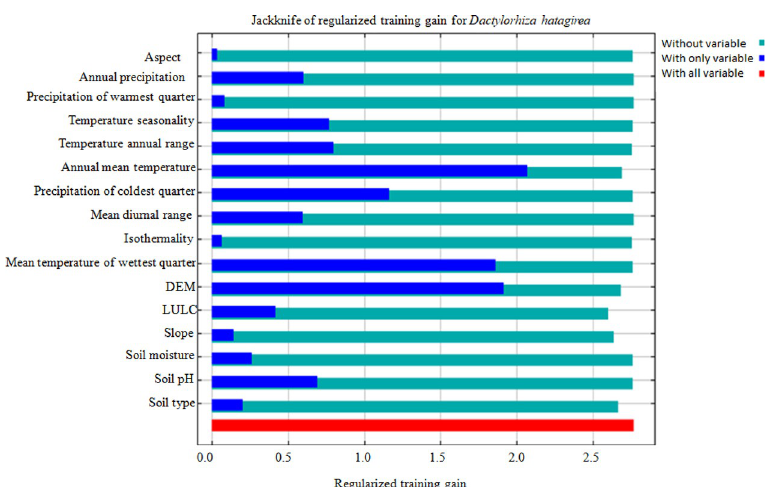
Fig 4. Results of jackknife test highlighting the relative importance of each variable when used in